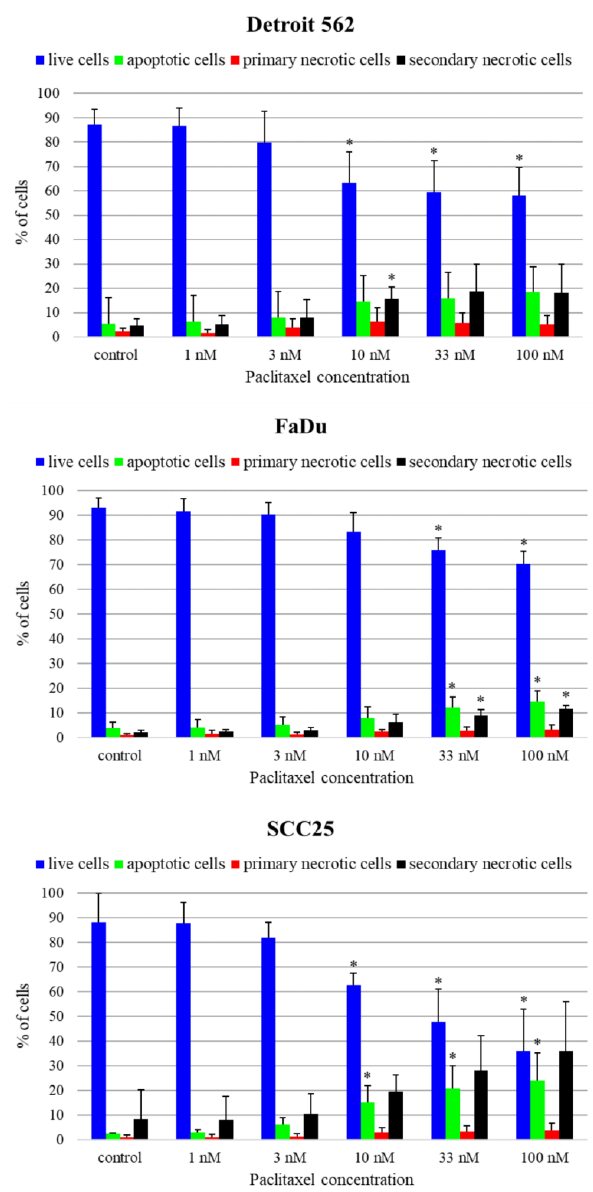
Figure 3. Paclitaxel-induced apoptosis of Detroit 562, FaDu and SCC25 cells. Annexin V-FLUOS / propidium iodide (Ann / PI)-stained HNSCC cells were analyzed by FACS (fluorescence-activated cell sorting) after 48 h of treatment with paclitaxel di ff erent concentrations. Live cells are presented by the Ann- / PI- fraction, apoptotic cells by the Ann +/ PI- fraction, secondary necrotic cells by the Ann +/ PI + fraction and primary necrotic cells are detected in the Ann- / PI + fraction. Data are presented as mean ± SD. Statistical analysis was performed by Student’s t -test, the cell fractions at all concentrations were compared to control fractions in each cell line * p <